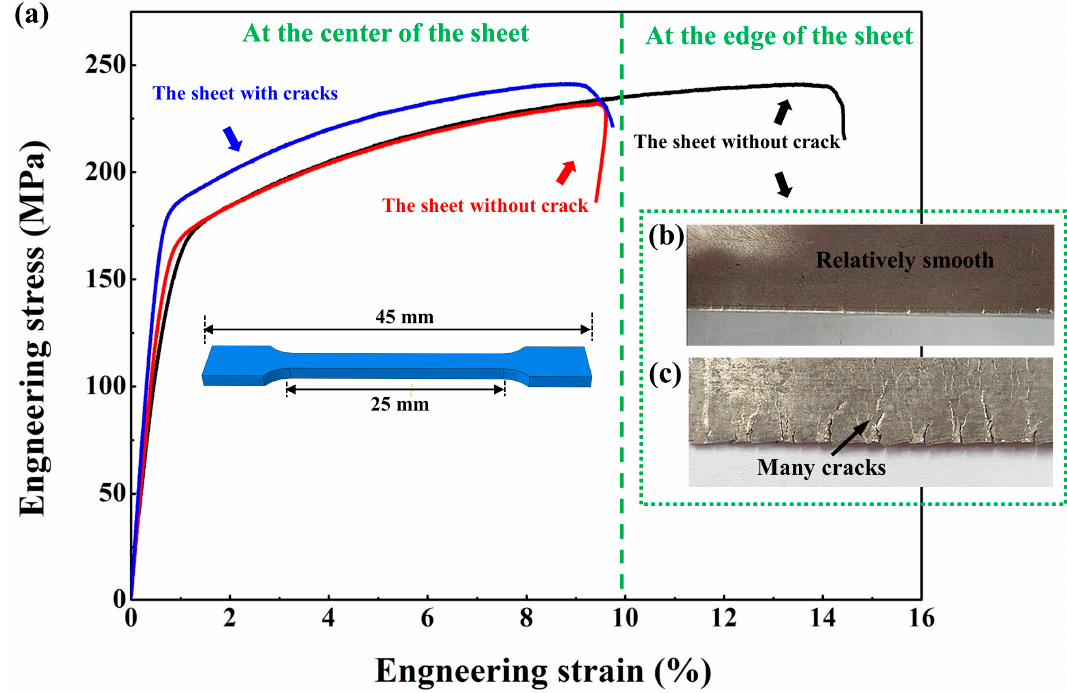
Figure 16. ( a ) Engineering stress–strain curve under tension of AZ31 rolled sheet at 50% thickness reduction after annealing for 473 K 6 h. ( b , c ) Edge crack situation.